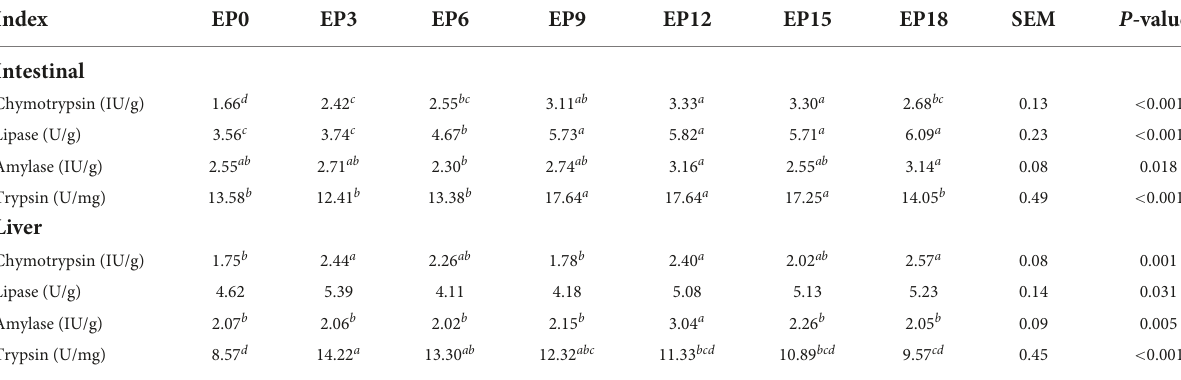
TABLE 5 Intestinal and liver digestive enzyme activities of hybrid groupers fed with